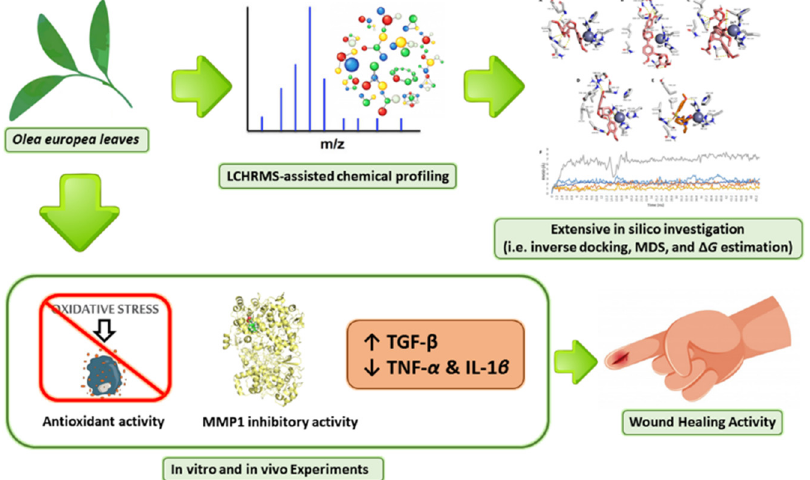
Figure 1. The general summary of the present research is as follows: Olea europaea leaves were extracted, chemical profiling was carried out, and finally the leaves were assessed for their potential wound healing activity by evaluating their antioxidant activity and ability to inhibit MMP1, upregu- late TGF- β relative gene expression, and downregulate the relative gene expression of inflammatory cytokines ( TNF- α and IL- β 1 ).